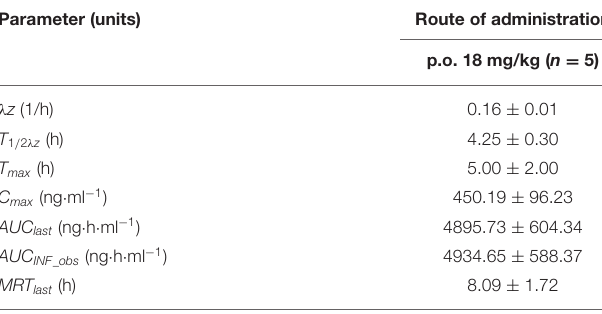
TABLE 1 | Plasma pharmacokinetic parameters after a single p.o. administration of 18 mg/kg b.w. vitacoxib. Parameter